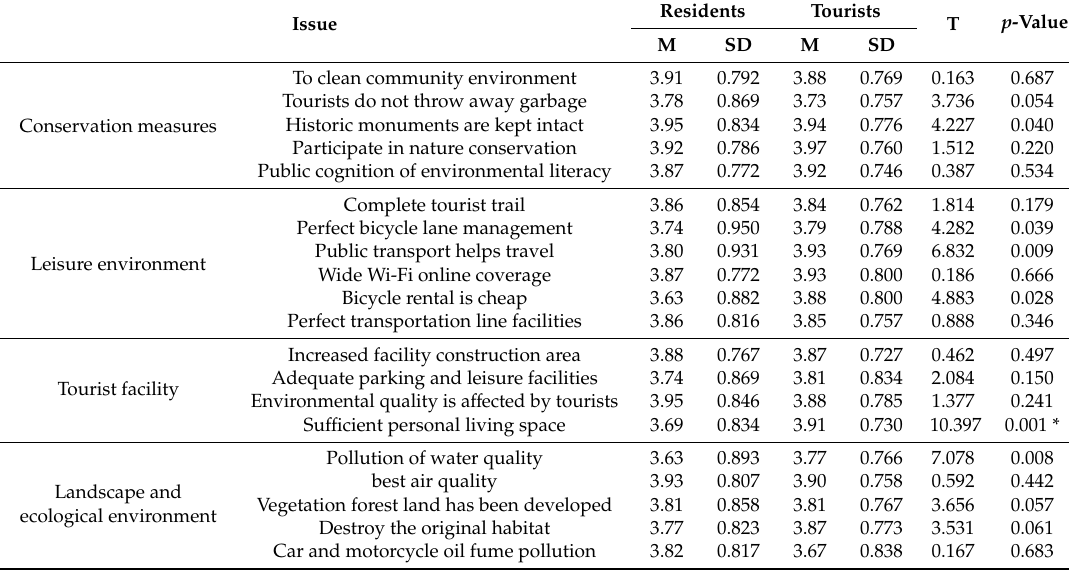
Table 10. Analysis of the di ff erences in awareness of the current state of environmental development among di ff erent stakeholders.